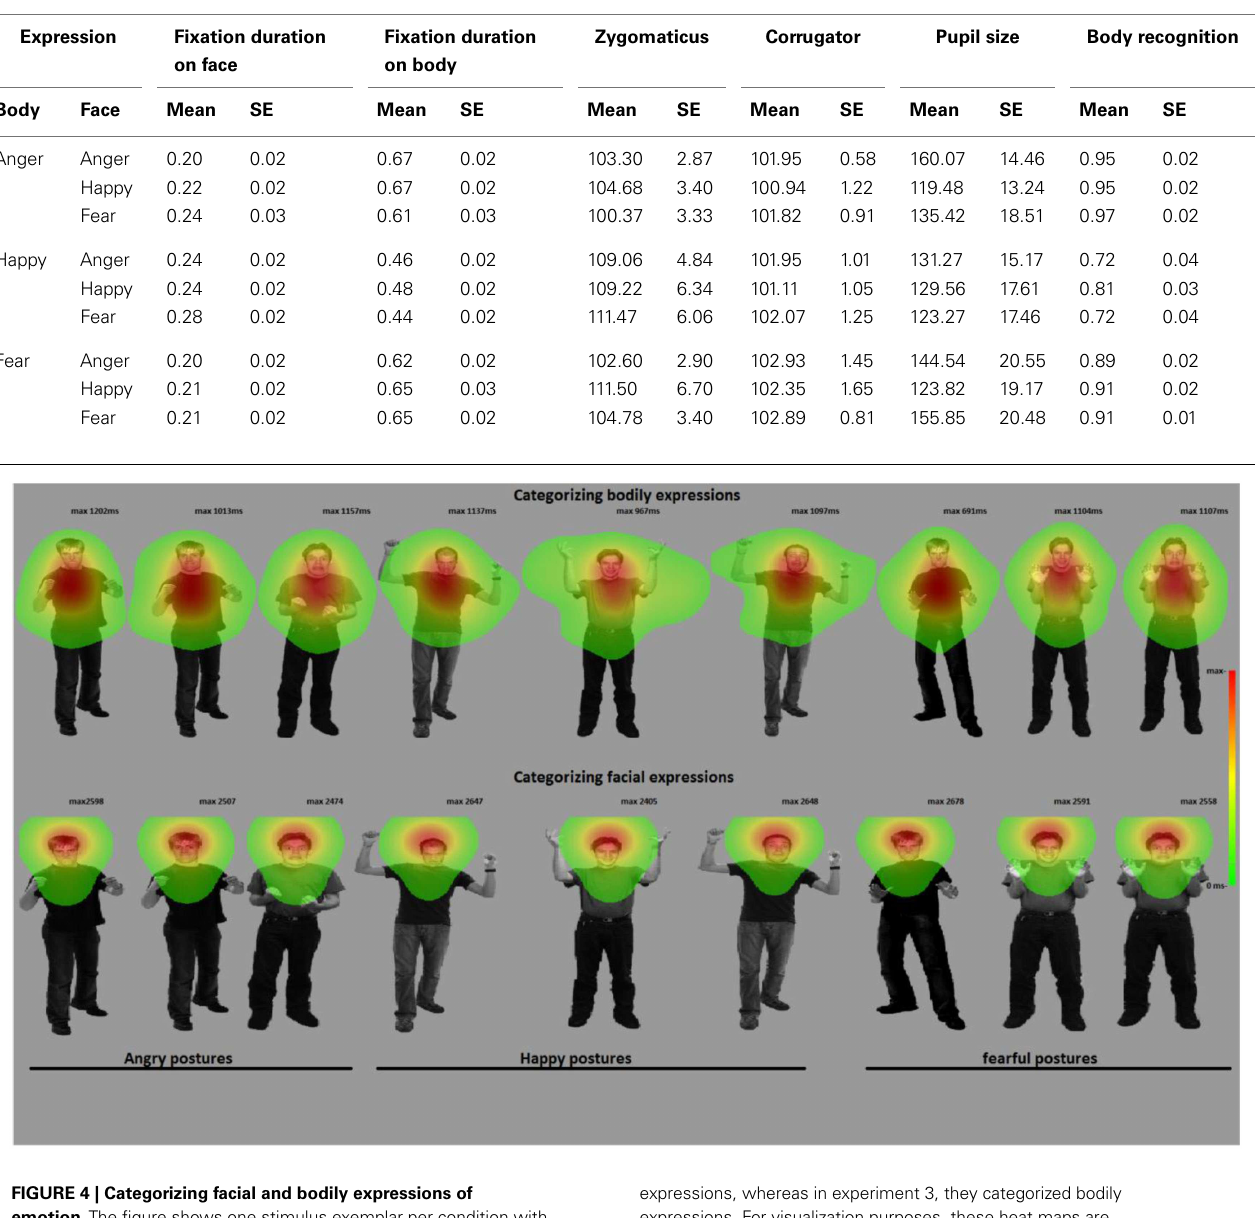
Table 2 | Means and standard errors.